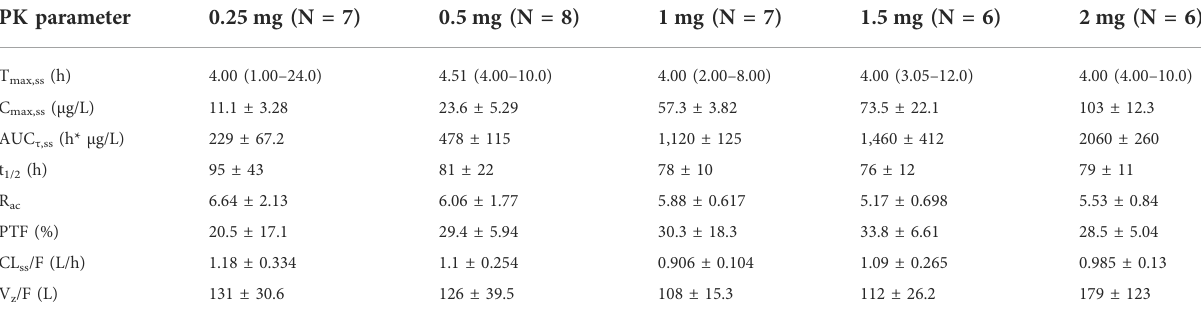
TABLE 3 Pharmacokinetic parameters of LC51-0255 after daily oral administration of 0.25, 0.5, 1, 1.5, or 2 mg of LC51-0255 for 21 days. PK